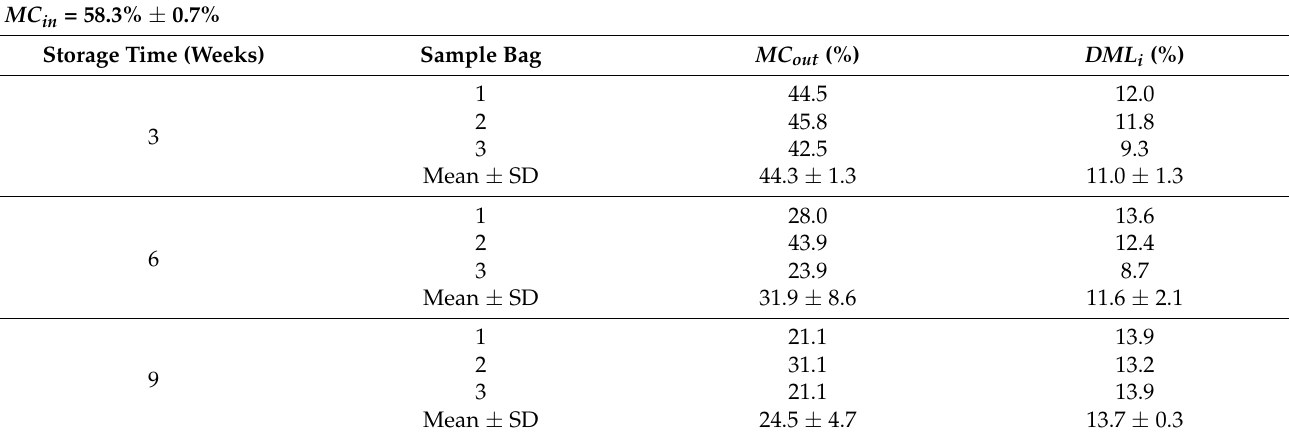
Table A3. Moisture content and dry matter losses of the sample bags in trial T3.